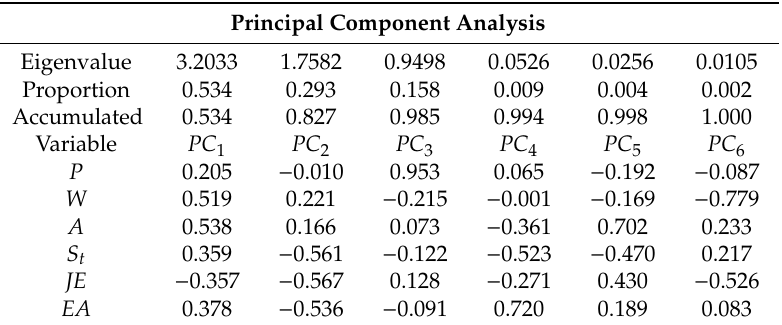
Table 15. Results of the principal component